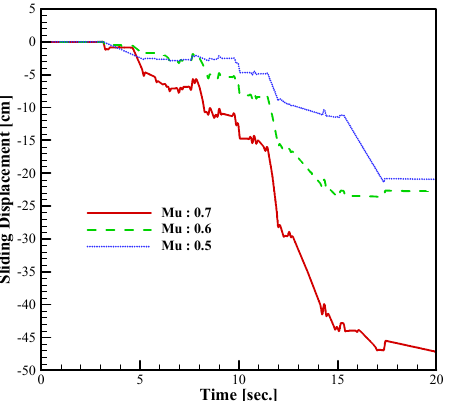
Figure 20. Displacement of sliding block under measured friction coefficients.